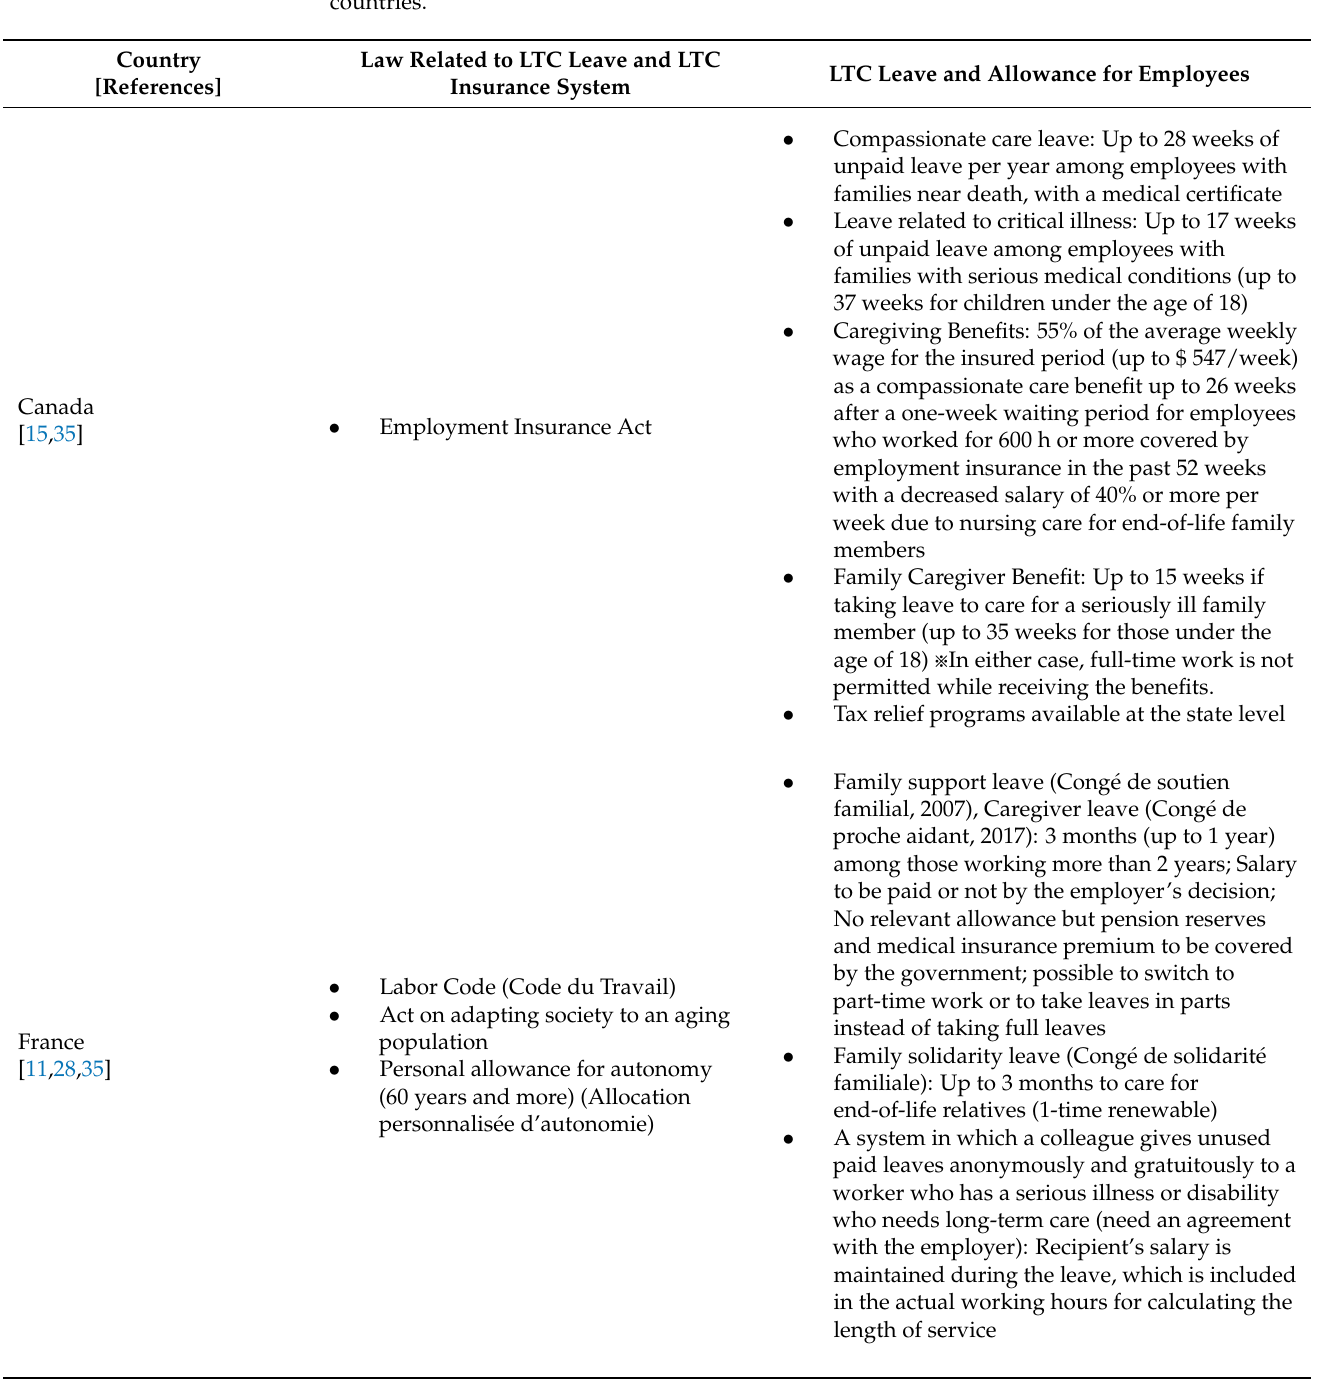
Table 3. Supports for employees of those in need of nursing or long-term care (LTC) in seven